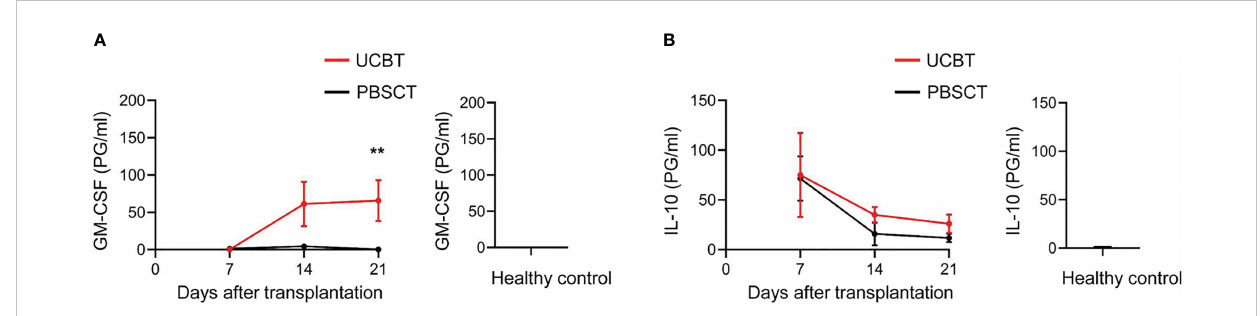
FIGURE 7 GM-CSF levels are elevated in patients after UCBT. ELISA assay results show the plasma levels of (A) GM-CSF and (B) IL-10 in the UCBT (n=9) and PBSCT (n=9) group of patients at different time points after HSCT. The histogram shows the data for the healthy control group (n=14). The data was analyzed by the Mann-Whitney U test and represented as means ± SEM. ** p